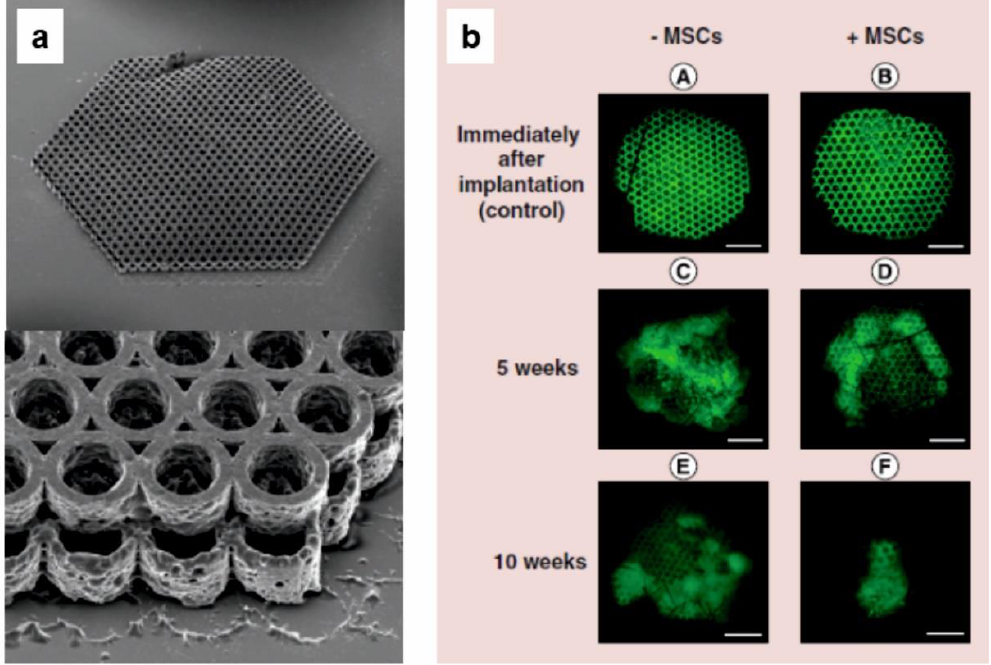
Figure 12. ( a ) Micrographs of a 2PP-fabricated PLA scaffold, ( b ) fluorescence of PLA scaffolds after implantation into mice; MSC—mesenchymal stem cell [71]. (Adapted from Future Medicine, 2016).